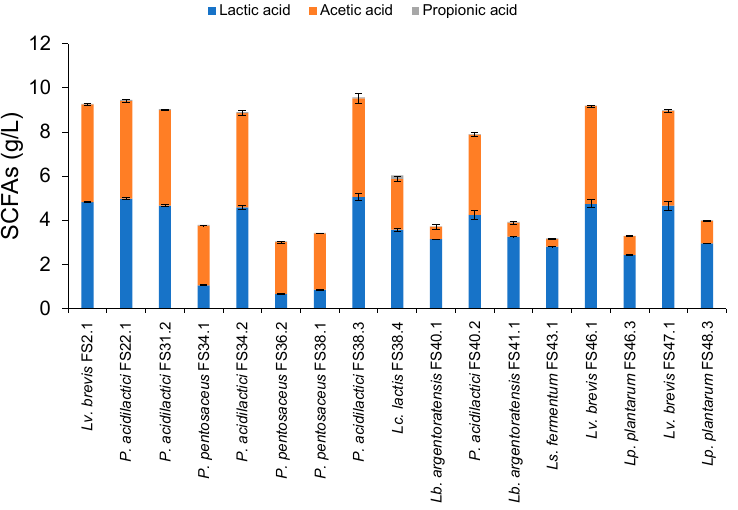
Figure 4. SCFAs production obtained from the selected XOSs-fermenting LAB after XOSs fermenta-